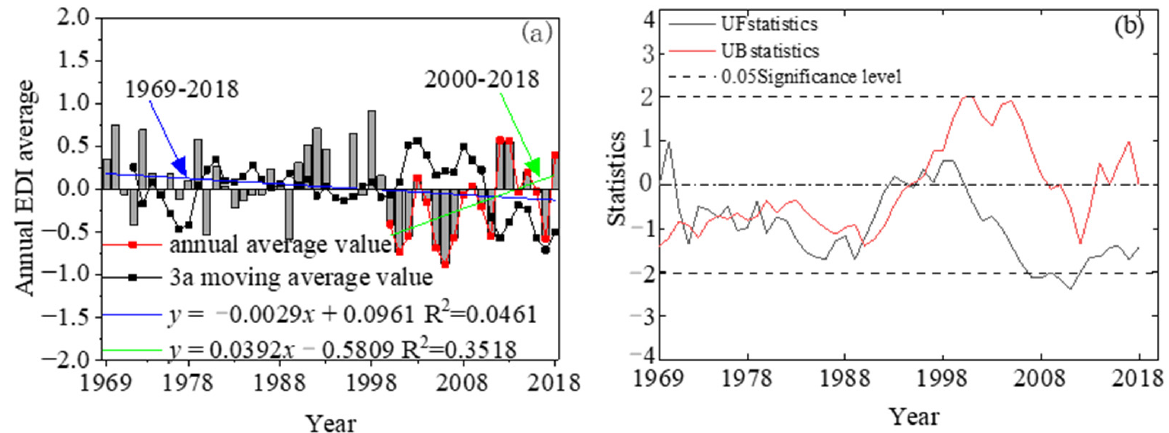
Figure 2. ( a ) Interannual variation characteristics of 1969–2018 EDI . ( b ) EDI interannual Mann–Kendall Test.